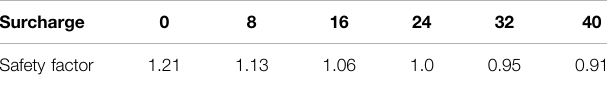
TABLE 2 | hange in the safety factor of the slope at different